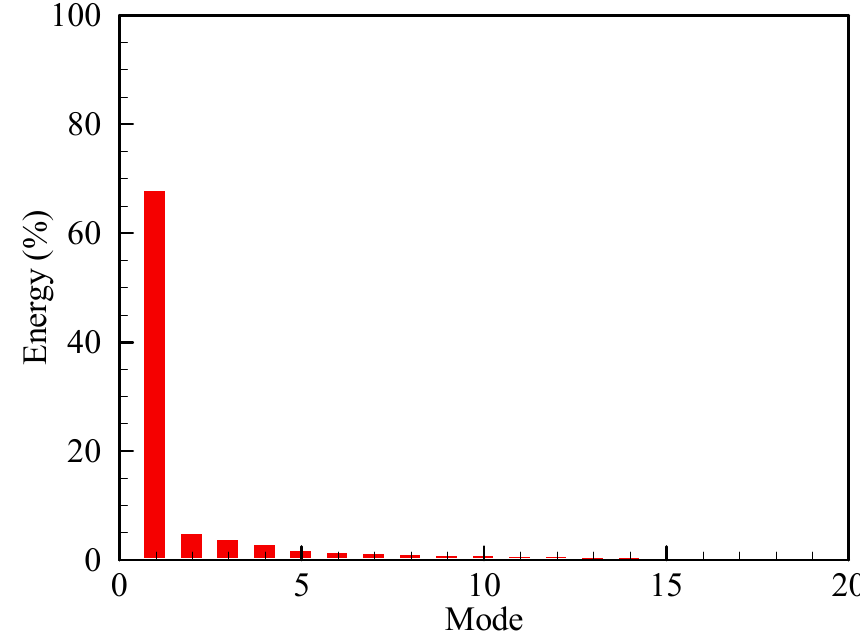
Figure 18. Energy distribution among the decomposed modes using POD with UCSD reaction mechanism for 200 × 300 grid resolution.